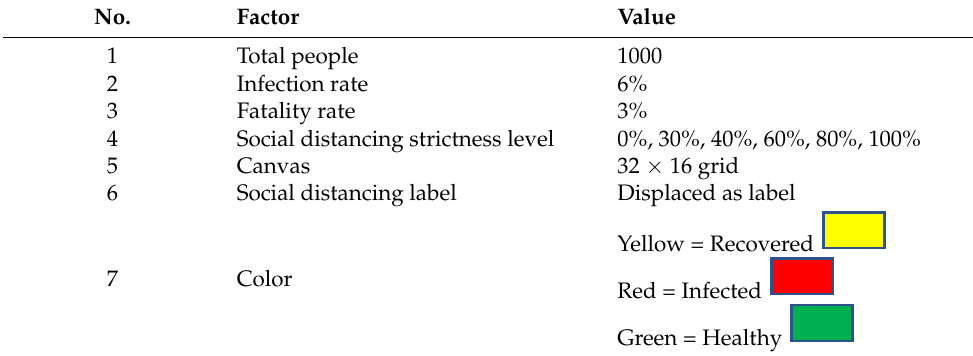
Table 1. The experiment factors and levels.